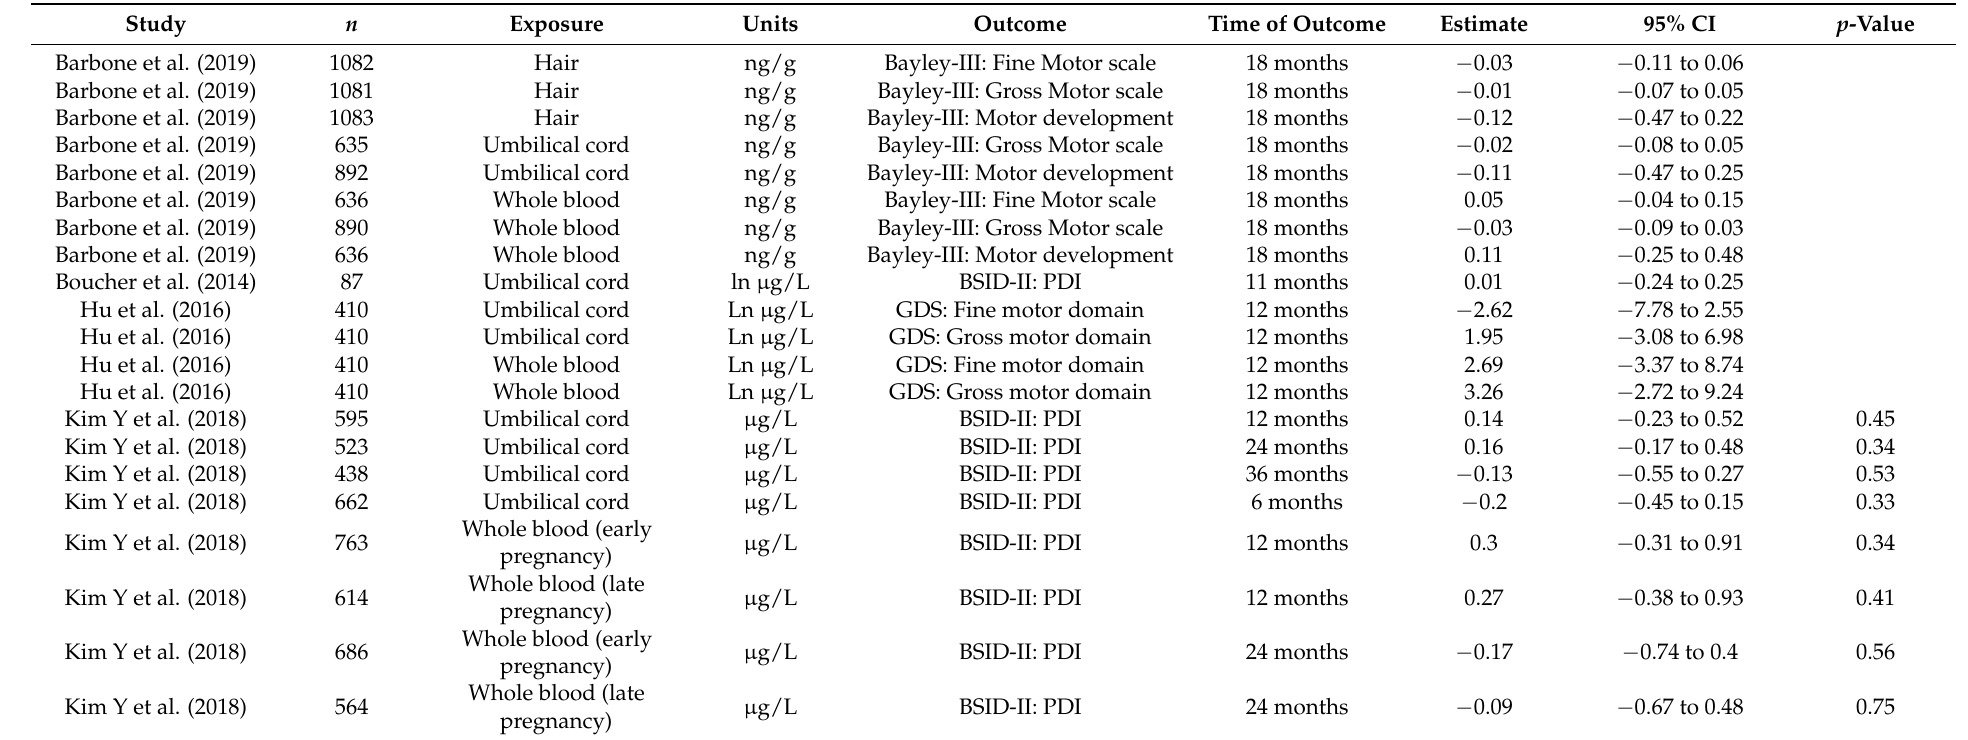
Table 6. Results from studies identified as high quality which measured motor function ( n =